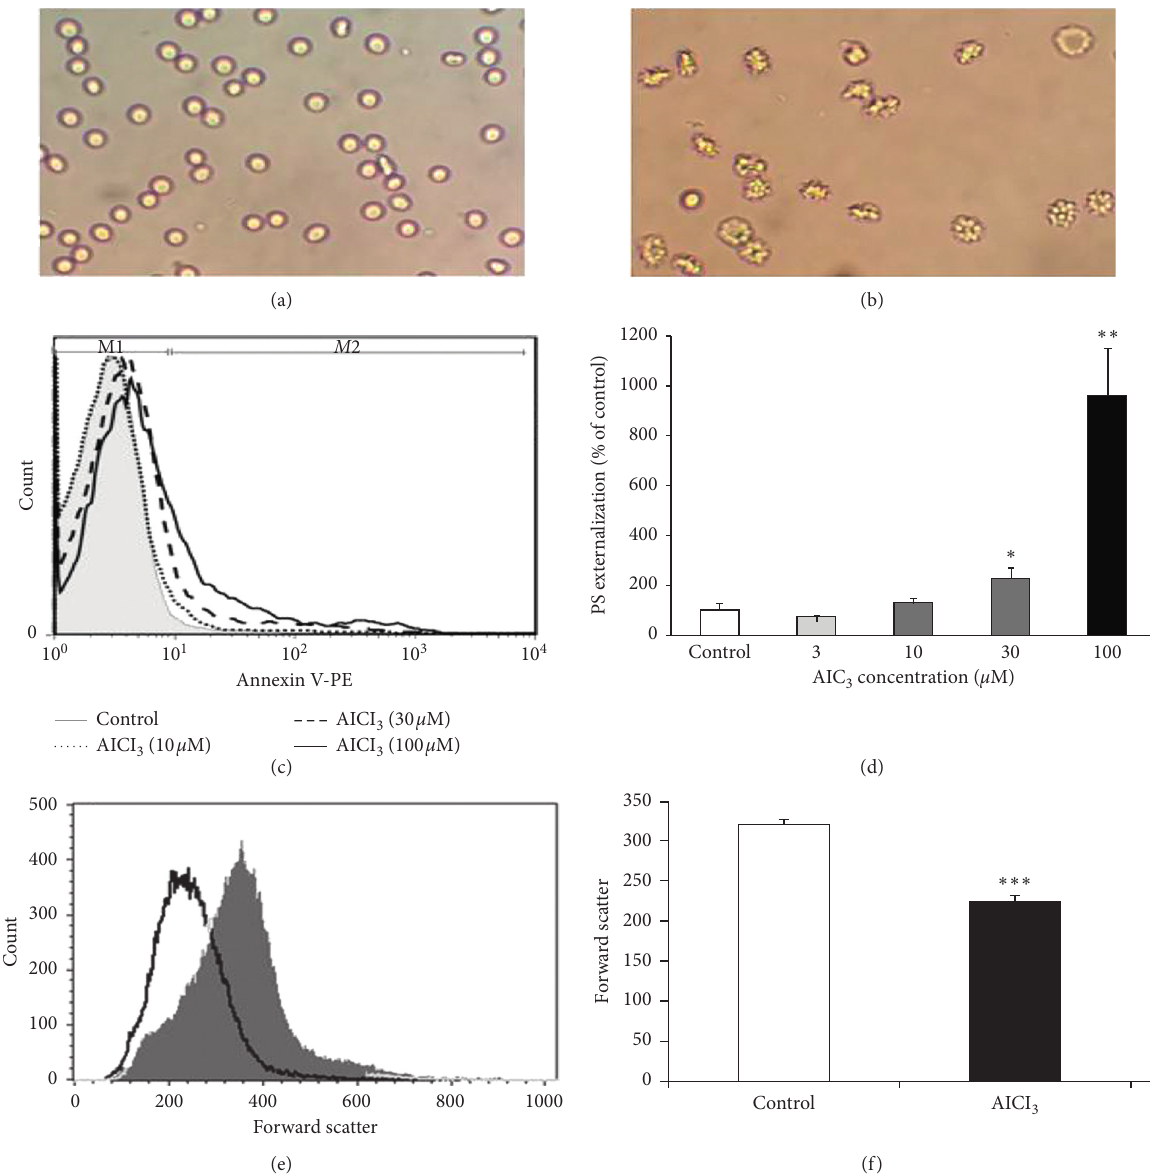
Figure 3: AlCl 3 induced membrane blebbing, PS externalization, and cell shrinkage in the erythrocytes. Micrographs showed normal shape erythrocytes in the control group (a) and membrane blebbing following treatment of erythrocytes with Ringer solution containing AlCl 3 (30 µ M) (b). Incubation with AlCl 3 (30 and 100 μ M) increased annexin V positive cells (c) and (d). Forward scatter in the erythrocytes ((e) and (f)) following exposure for 24hours to Ringer solution (control; grey area), AlCl 3 (100 μ M; black